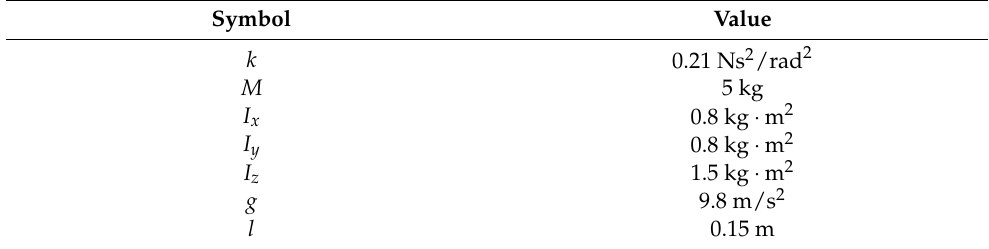
Table 1. Parameters of the quadrotor